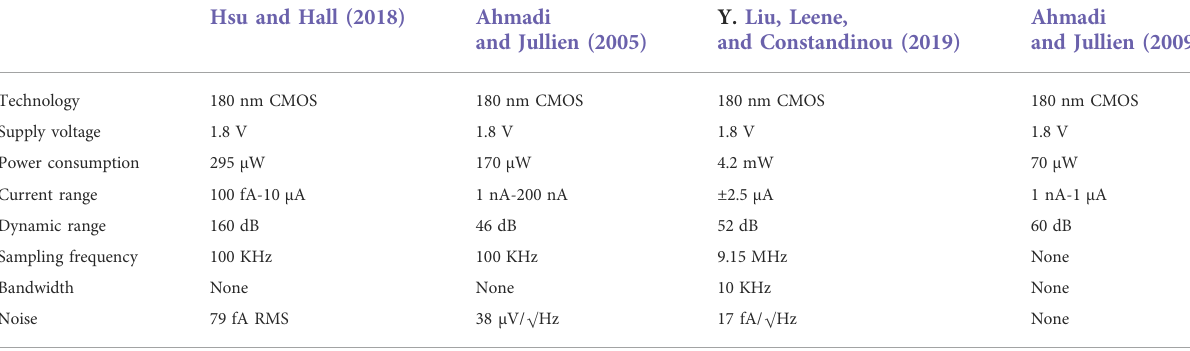
TABLE 4 Performance, summary, and comparison of the I – F convertor-based sensing front ends.